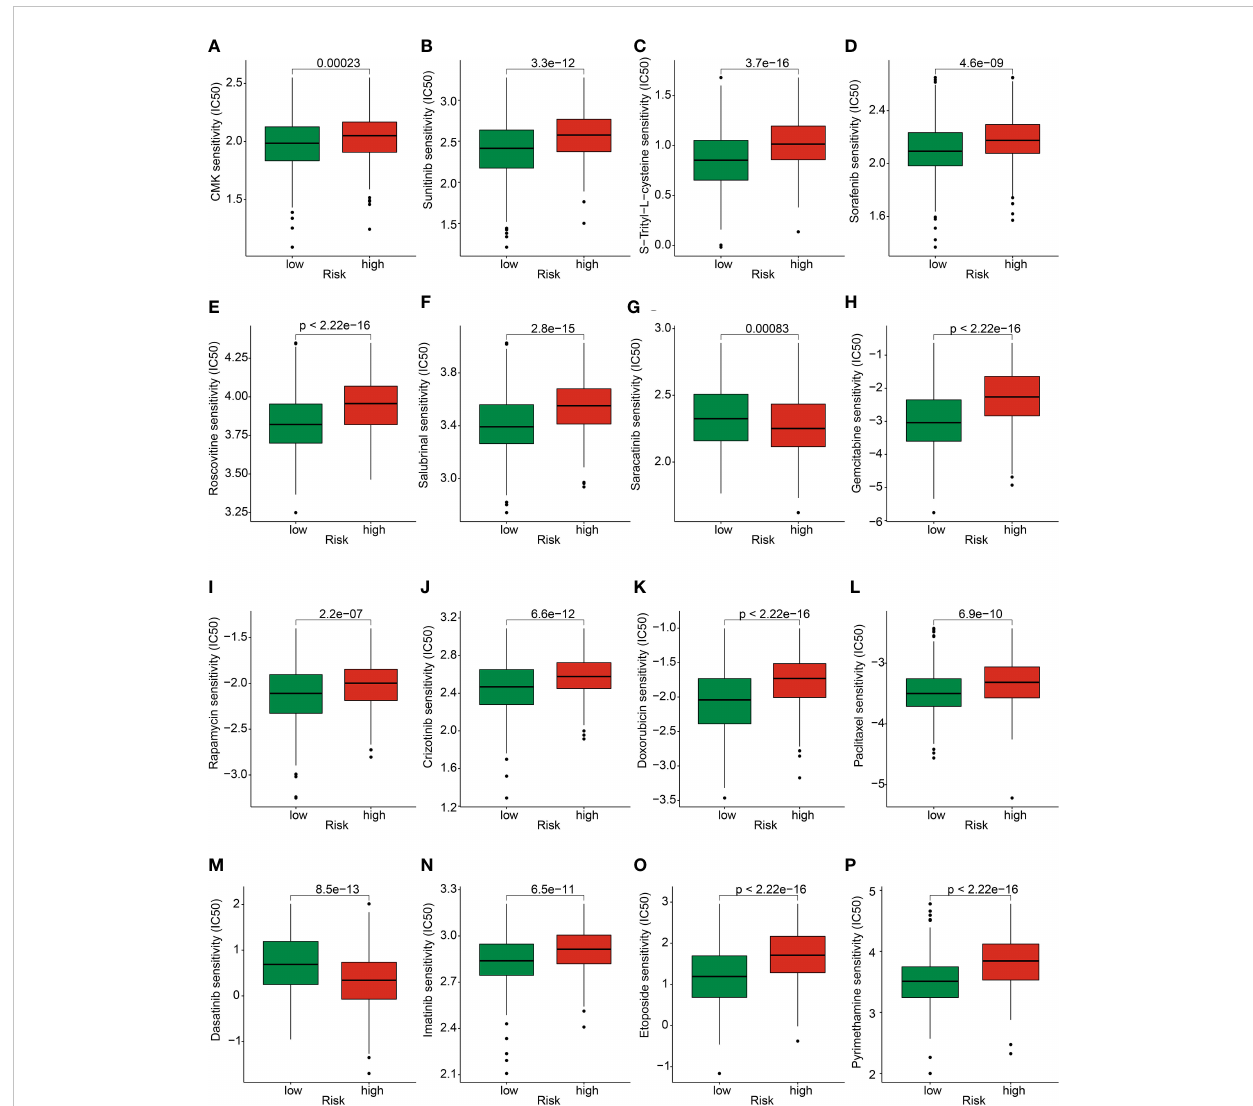
FIGURE 11 Prediction of chemotherapy drug for GC in risk subgroups. The IC50 distribution of (A) CMK, (B) Sunitinib, (C) S-Trityl-L-cysteine, (D) Sorafenib, (E) Roscovitine, (F) Salubrinal, (G) Saracatinib, (H) Gemcitabine, (I) Rapamycin, (J) Crizotinib, (K) Doxorubicin, (L) Paclitaxel, (M) Dasatinib, (N) Imatinib, (O) Etoposide, and (P) Pyrimethamine between low- and high-risk